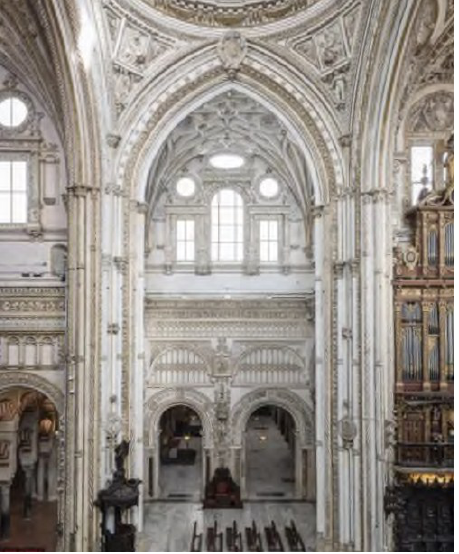
Figure 6. Hernan Ruiz I. Transept. Mosque-Cathedral of Cordoba. © Cabildo Catedral de Córdoba.